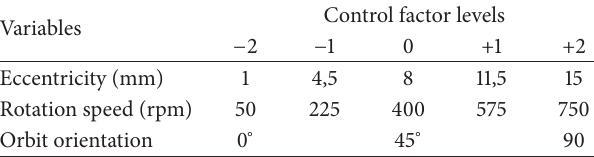
Table 1: Response surface design matrix.